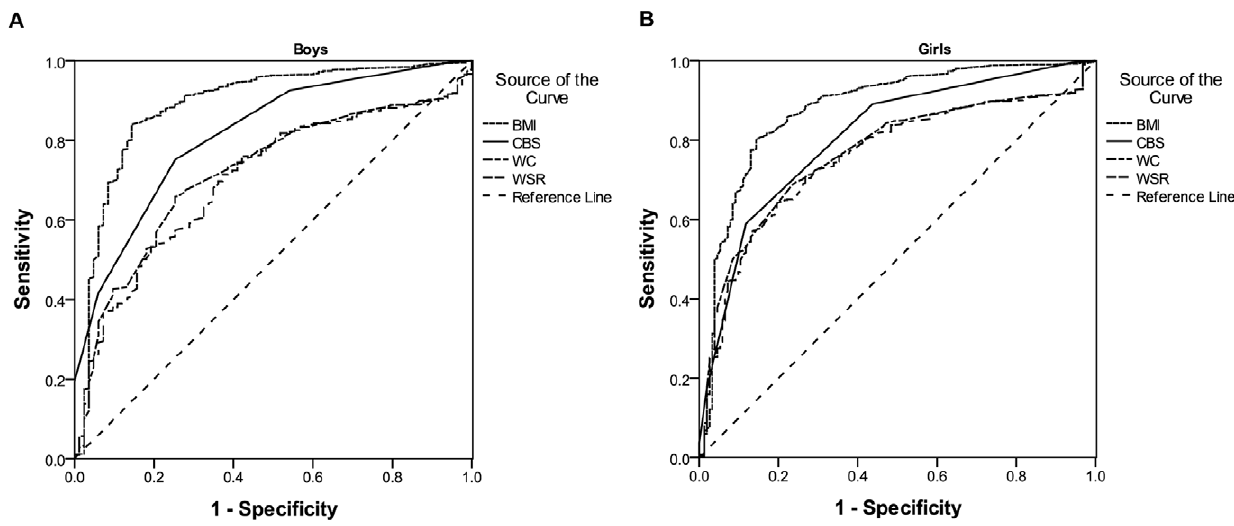
Figure 1. Receiver operating characteristic (ROC) curves for underweight in boys and girls. Apart from BMI, CBS had the greatest AUC in both boys and girls. (A) AUC for boys: self-reported BMI (0.89); CBS (0.82); self-reported WC (0.72); self-reported WSR (0.70). (B) AUC for girls: self- reported BMI (0.88); CBS (0.81); self-reported WC (0.77); self-reported WSR (0.76).